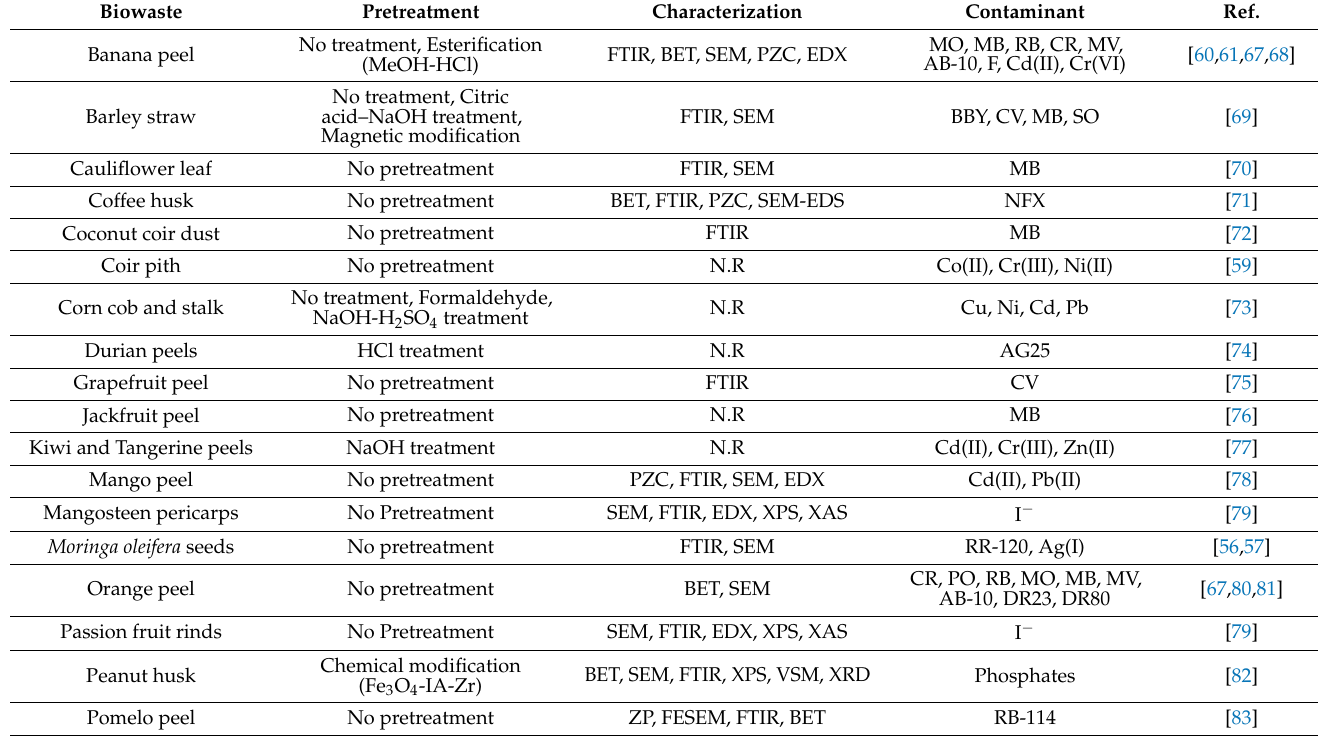
Table 2. Pretreated and non-treated raw biowastes implemented as bioadsorbents to remove a wide variety of heavy metals, industrial contaminants, ions, and